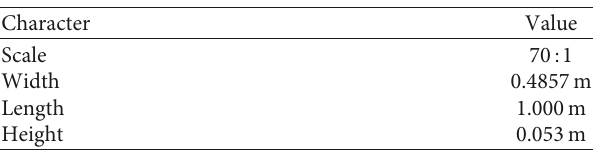
Table 1: Dimensions of test